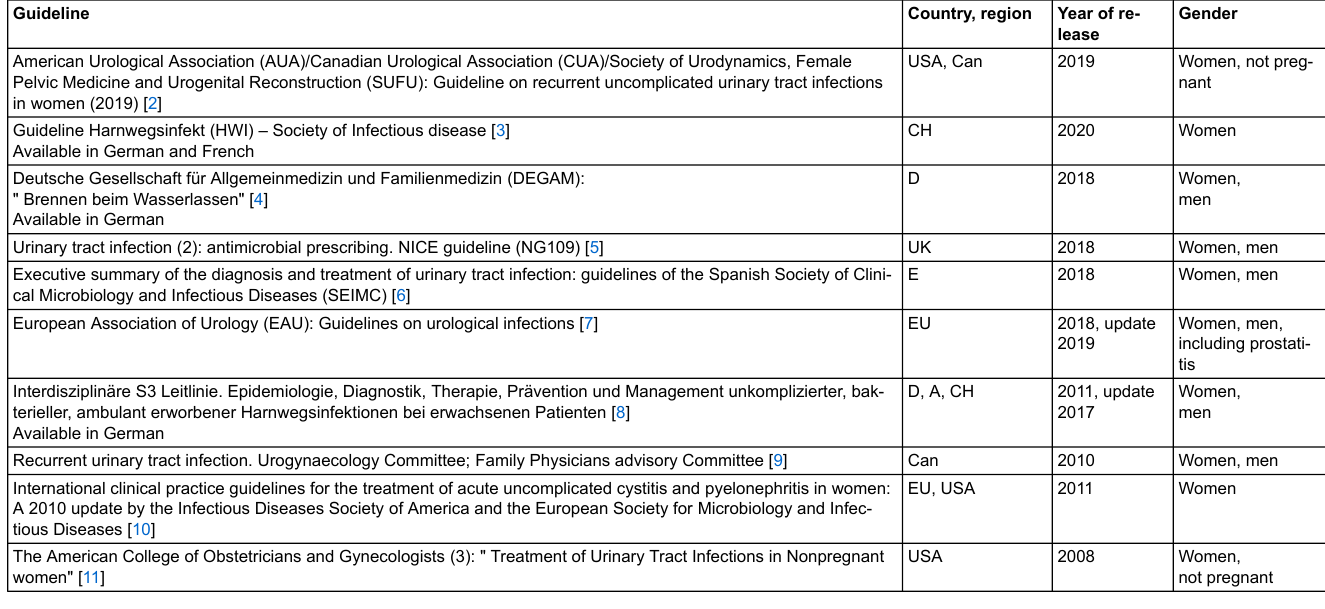
Table 1: National and international guidelines on urinary tract infections addressing UTIs in adults. Guidelines for children, immunocompromised patients or patients with urinary catheters are not listed.